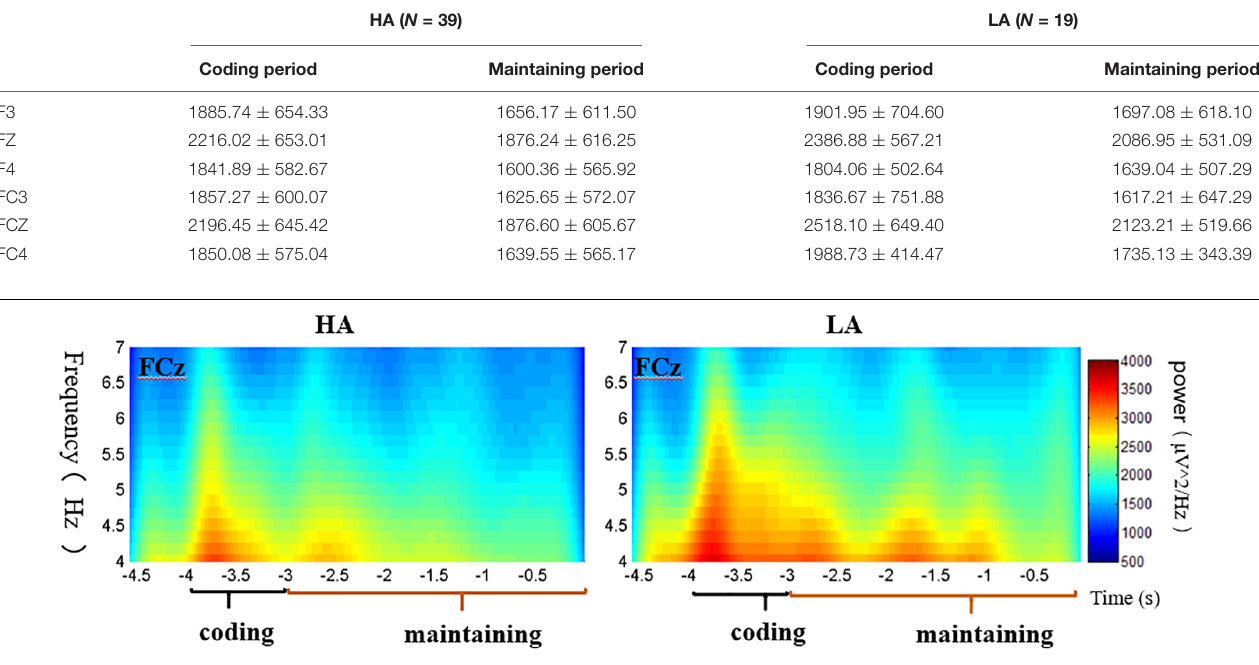
FIGURE 5 | Average spectrograms at FCz site of HA (left) and LA (right) groups.